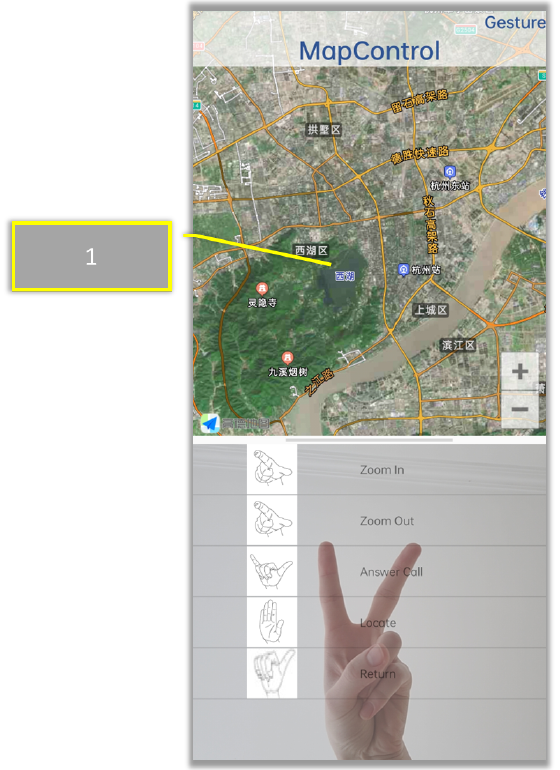
Figure 8. Map control interface. No.1 represents the position displayed on the